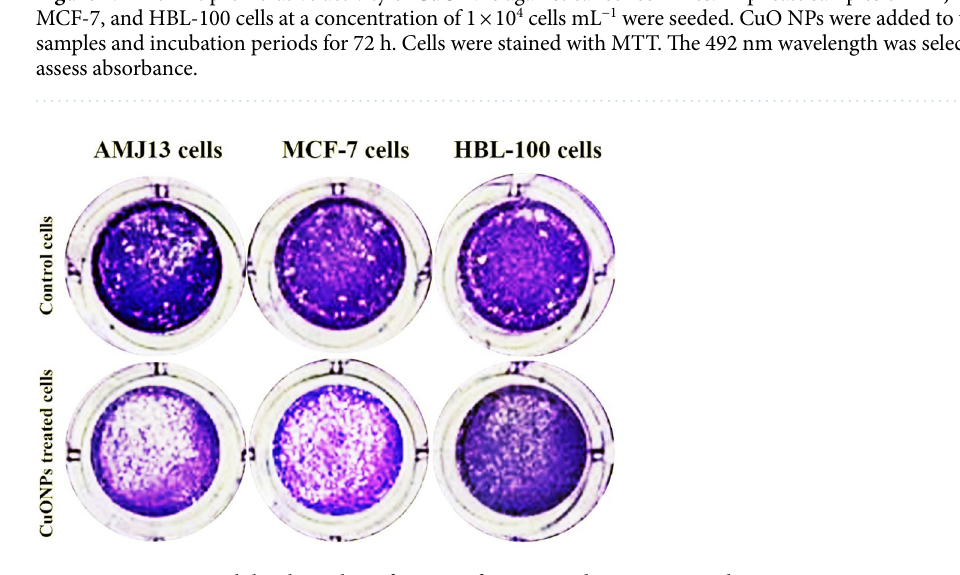
Figure 5. CuONPs inhibit the Colony-forming of MCF-7 and AMJ-13. A 24-h CuONPs treatment was provided at IC50 concentration, followed by crystal violet staining for 20